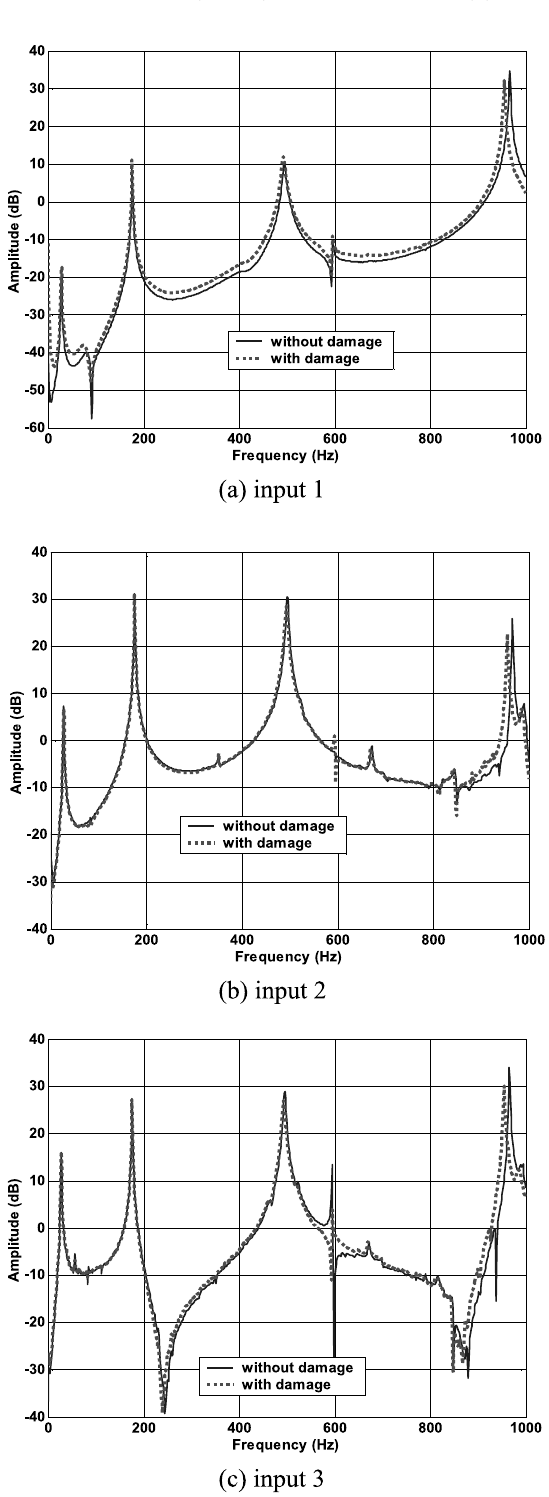
Fig. 9. Experimental Frequency Response Functions for the healthy and the damaged structure for the set-up shown in Fig. 8 [dB ref 1m/s 2